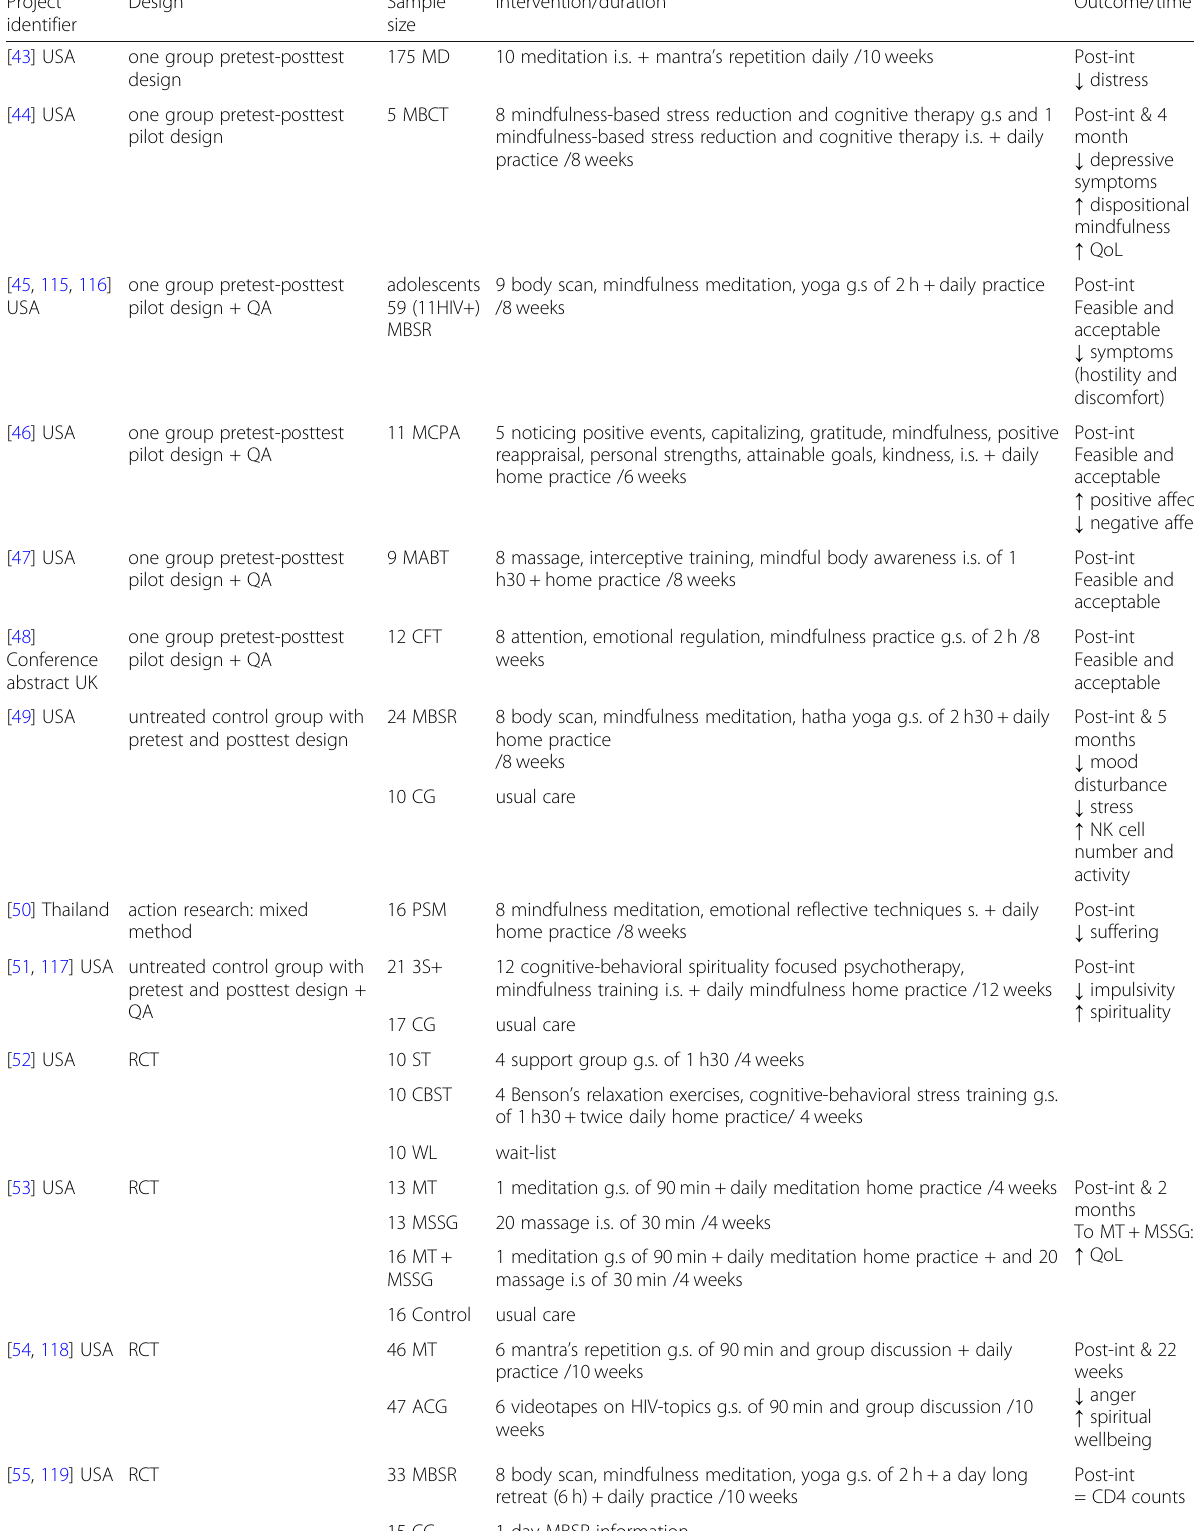
Table 5 Meditation included